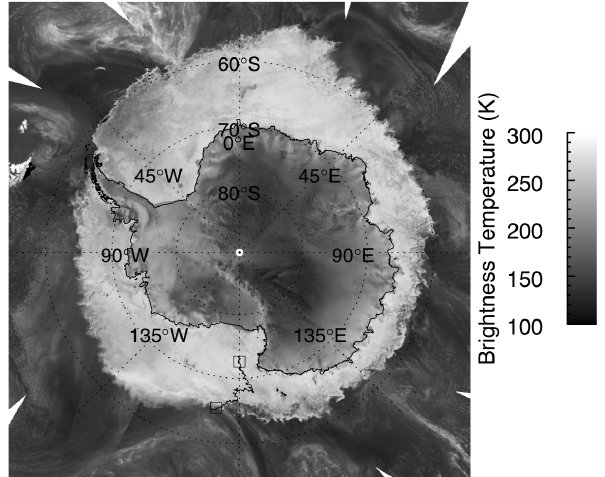
Figure 8. Map of ASC horizontal T B image on 13 September 2017. Black trajectory and square boxes display subsets at start and end of the Ross Sea